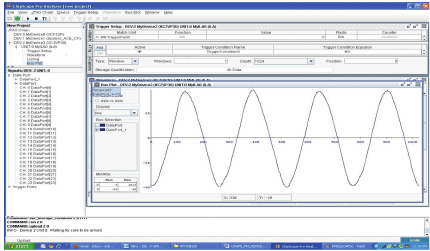
Figure 17: On-chip-verified result of the FM demodulator output for the triangular wave-modulated